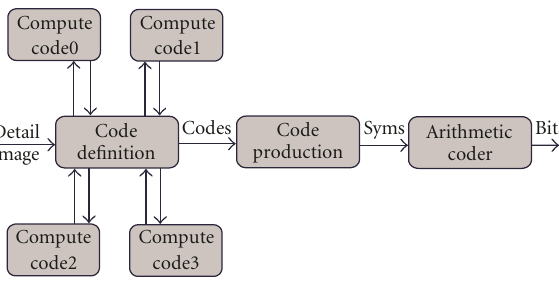
Figure 5: Task diagram for configuration par-b of the EZT coder. Thin lines are scalar FIFOs and thick lines are block FIFOs. Table 3: Experimental results for di ff erent parallelizations of the MPEG-4 simple profile encoder. Configuration No. of